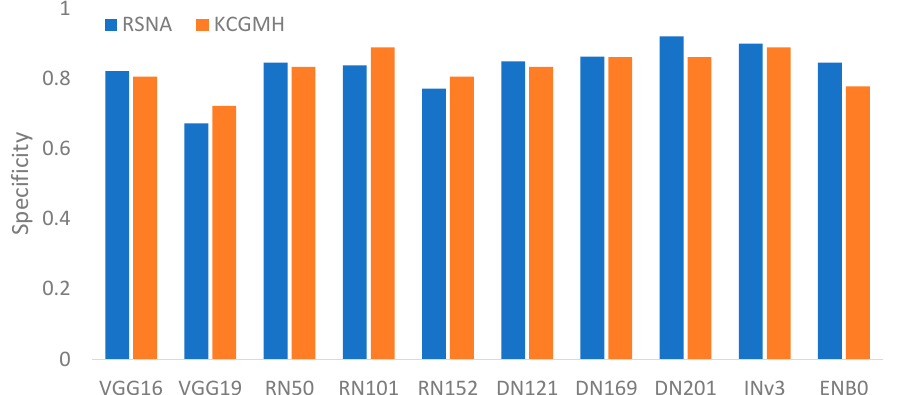
Figure 15. Specificity comparisons of using RSNA data and KCGMH data for the recognition mod-